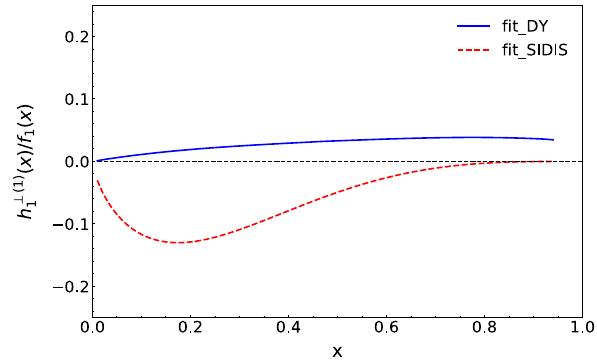
( x )/ f ( x ) for u quark at Q 2 = 25 GeV 2 . The Fig. 1 The ratio h ⊥ ( 1 ) 1 1 solidbluelinecorresponds totheDYextraction[12],andthedashedred linecorrespondtotheSIDISextraction[13]oftheprotonBoer–Mulders